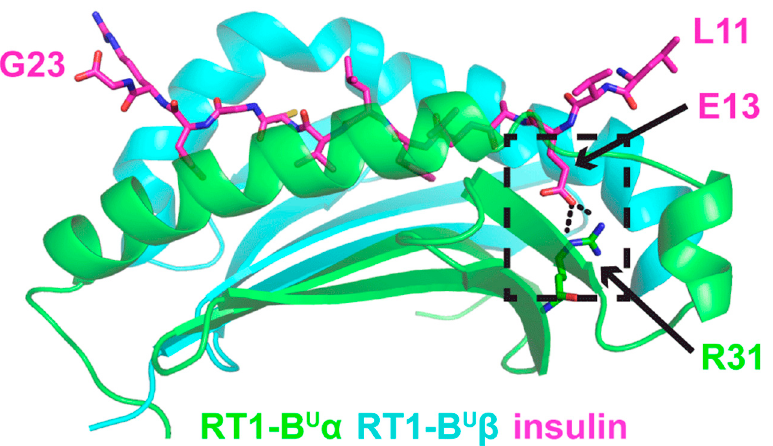
Figure 3. Structural model of insulin B peptide presented by RT1-B u MHC. RT1-B u α and β chains are shown as cartoons and colored green and cyan, respectively. Insulin B residues 11-23 are present in the model, and are shown in stick representation, colored magenta. Putative salt bridge interaction between peptide residue glutamic acid 13 (E13) and MHC α residue arginine 31 (R31) is shown in the black dashed box.